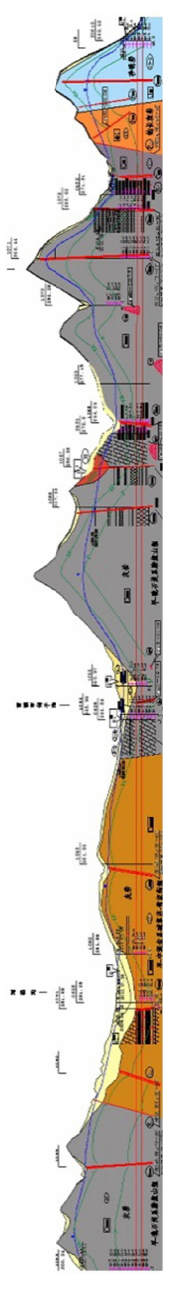
Figure 2. The sketch of some part of geological condition in